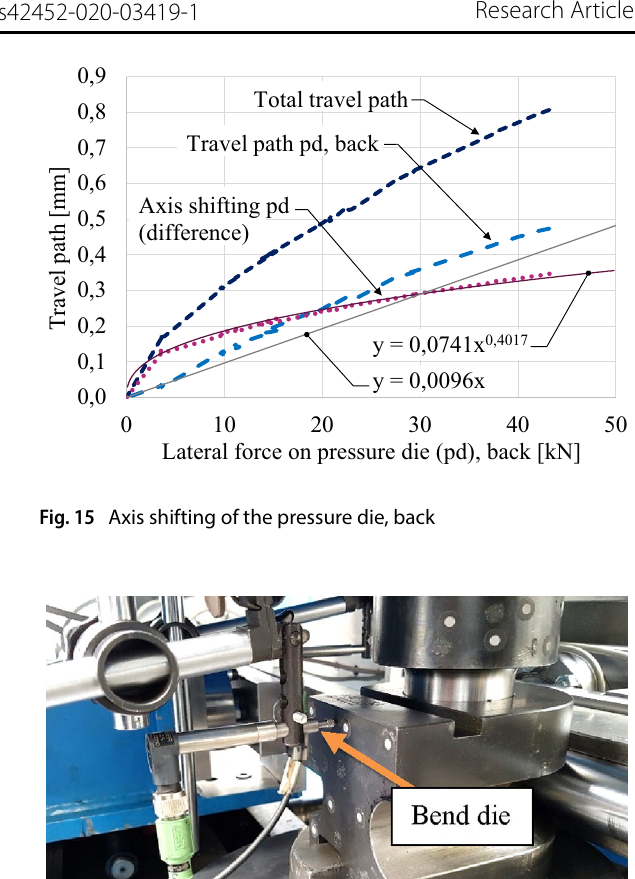
y = 0,0534x 0,5259